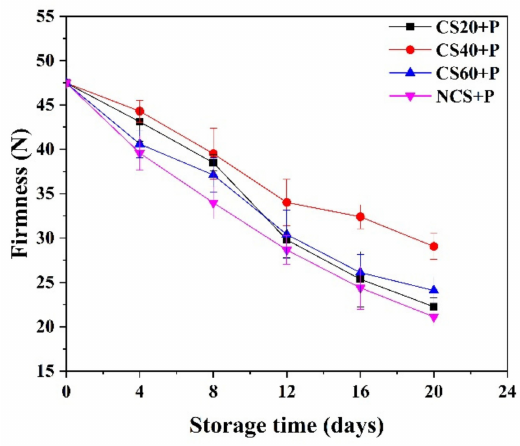
Figure 3. Effect of different treatments on the firmness of cucumbers during storage at 13 ± 2 ◦ C. CS20+P—packaged after 20 min of cold shock; CS40+P—packaged after 40 min of cold shock; CS60+P—packaged after 60 min of cold shock; NCS+P—packaged after 0 min of cold shock.